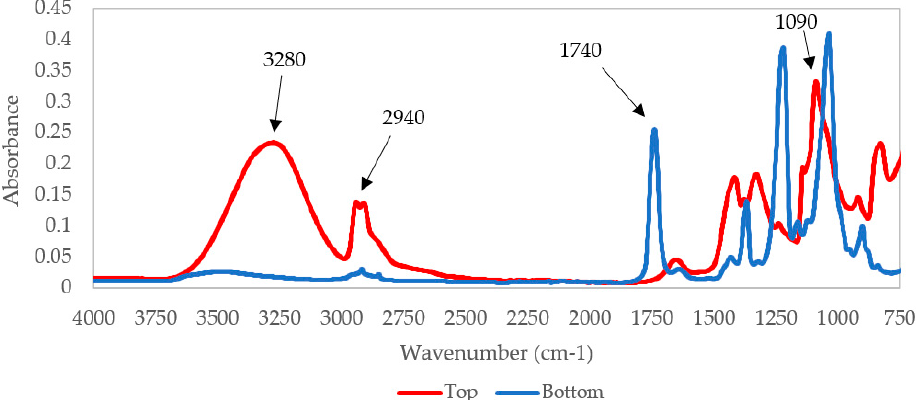
Figure 1. FTIR spectra of the top (coated) and bottom (uncoated) sides of the poly vinyl alcohol (PVA)-Ag membrane.